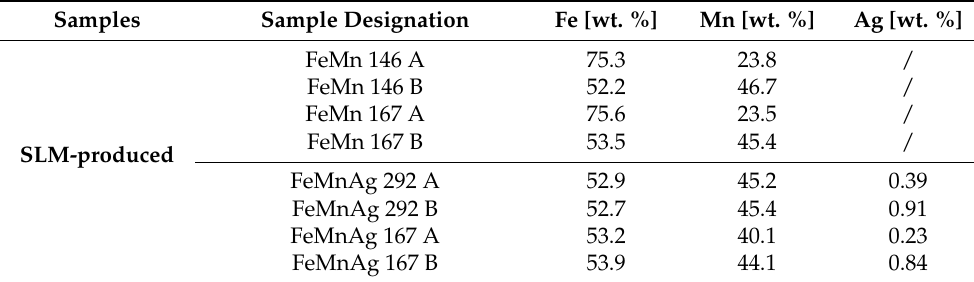
Table 2. Chemical composition of selective laser melting (SLM)-produced parts. SLM-produced samples. The number in the designation after the SLM-printed part ´ s chemical composition is the value of the energy density and the A or B mark means the first print or reprint. The remaining wt. % belongs to the oxygen